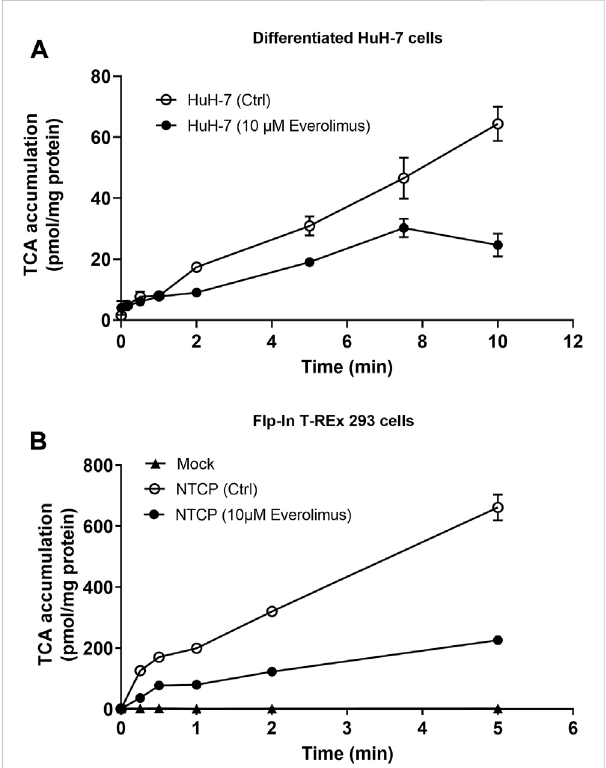
Inhibition of NTCP-mediated taurocholate (TCA) transport by everolimus over time. Accumulation of [ 3 H]-TCA (2 μ M; 200 nCi/mL) in extracellular fl uid buffer (ECF) with Na + over 5 or 10 min in the absence (DMSO Ctrl; 0.1%) and presence of everolimus (10 µM) was measured in (A) differentiated HuH-7 cells, and (B) stably transfected Mock-GFP and NTCP-GFP-expressing Flp-In ™ T-REx ™ 293 cells. Mock-GFP or NTCP-GFP were induced in Flp-In ™ T-REx ™ 293 cells with 1 μ g/mL doxycycline for three days. All data were plotted as mean ± SD ( n = 3). Error bars are not visible when the SD is smaller than the data